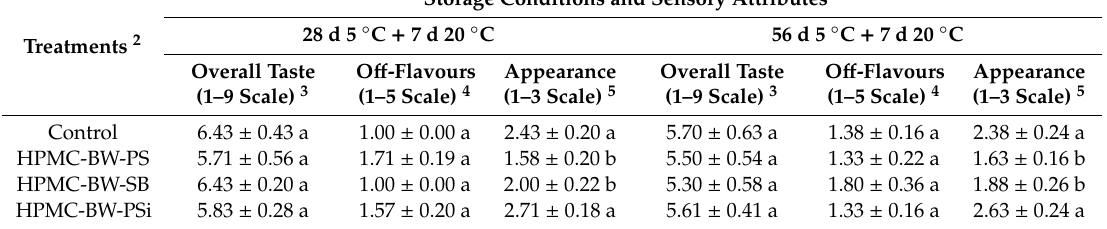
Table 4. Sensory quality attributes of “Valencia” oranges coated with hydroxypropyl methylcellulose (HPMC)-beeswax (BW) composite edible coatings containing GRAS salts and stored at 5 ◦ C followed by 7 d of shelf life at 20 ◦